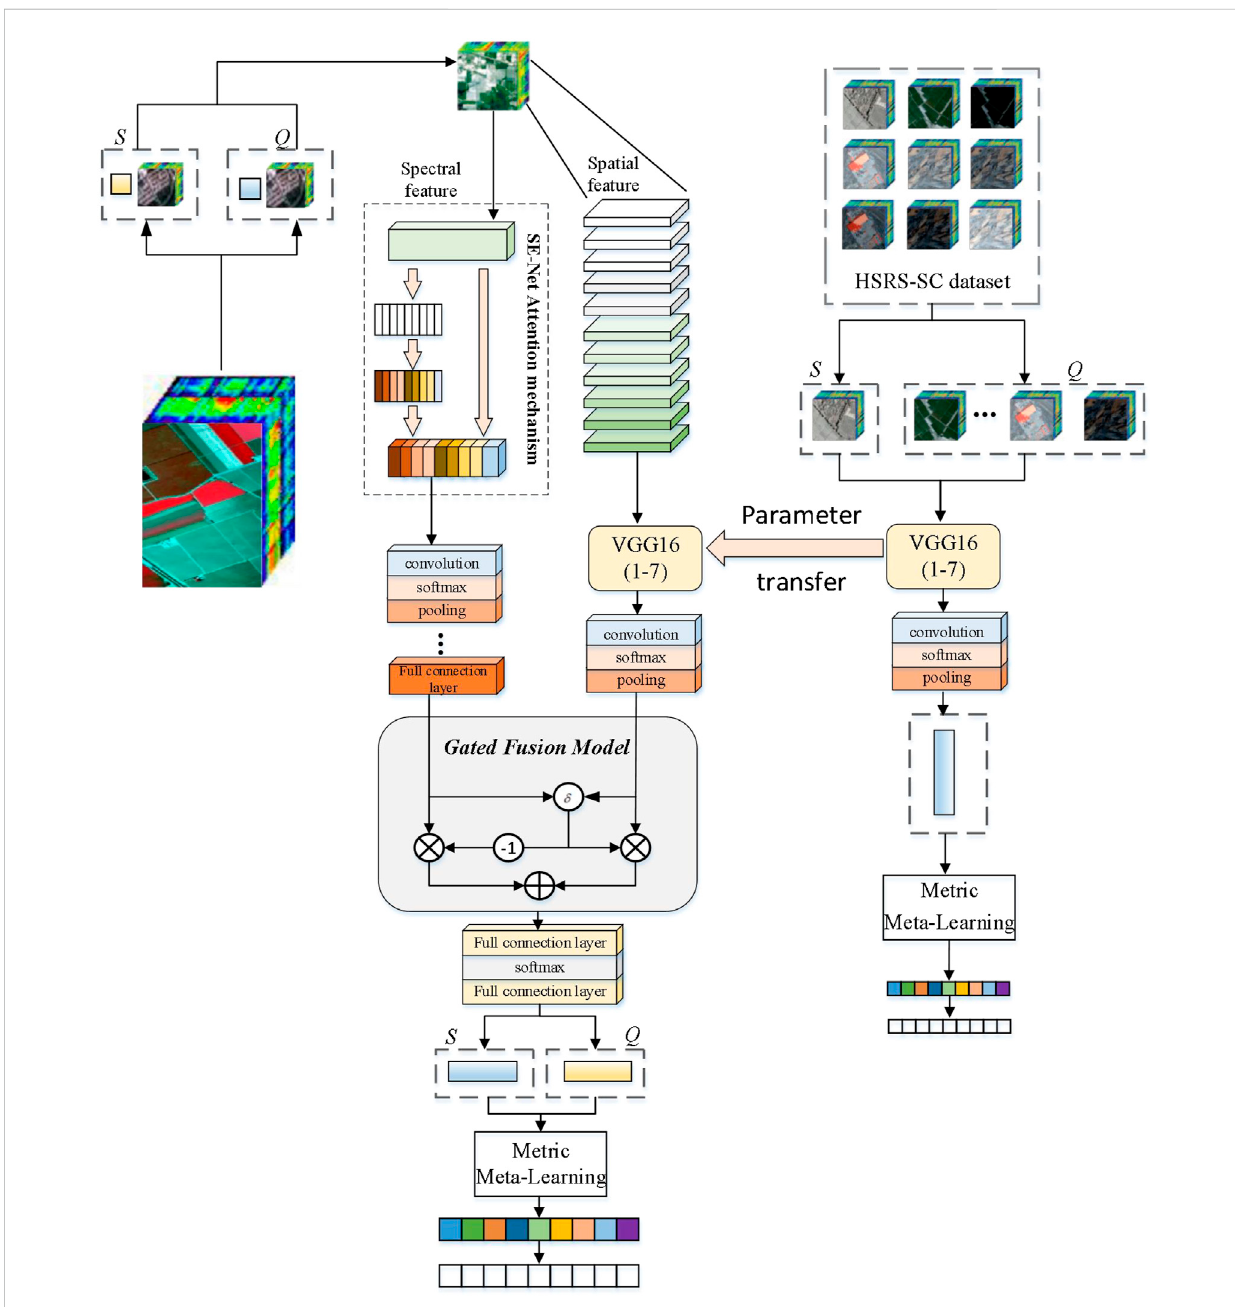
FIGURE 1 Joint spectral – spatial classi fi cation network based on the metric meta-learning